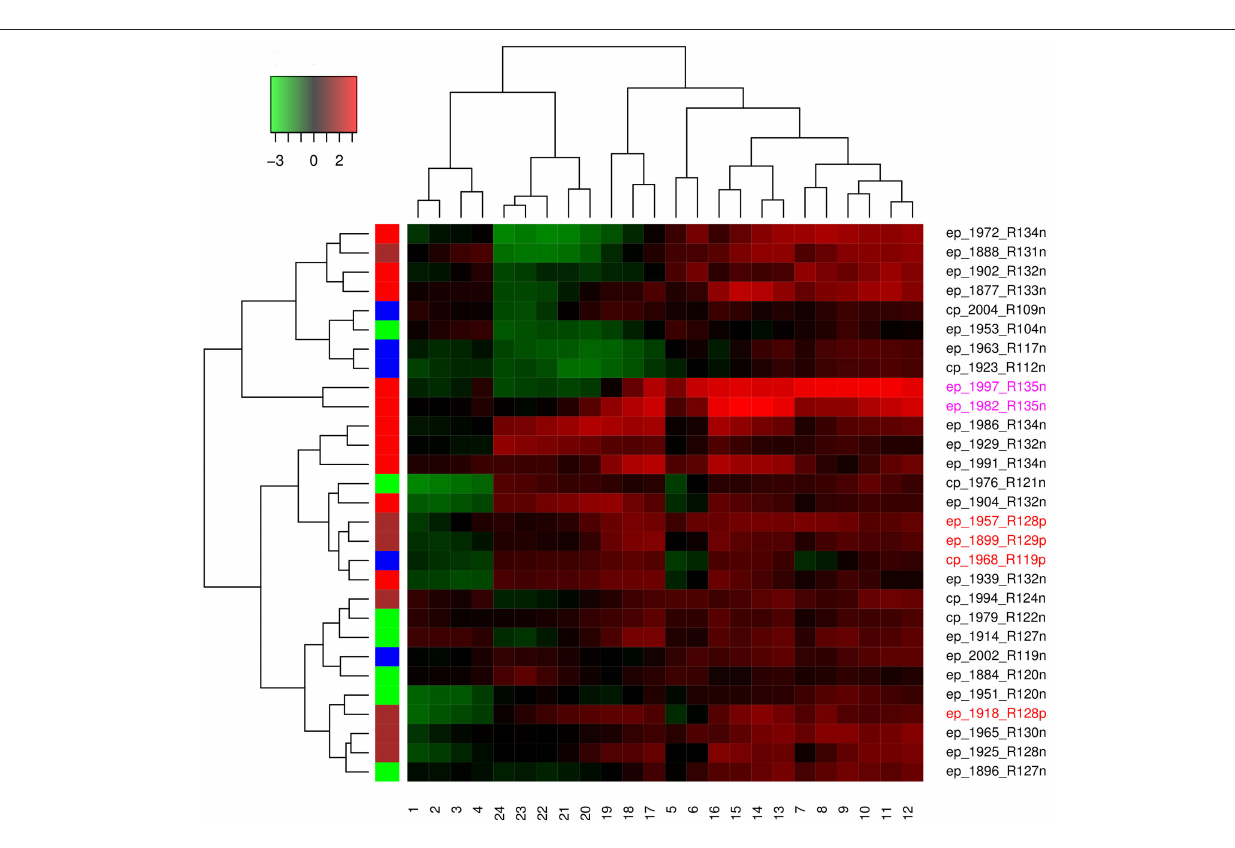
to December), but high from 7 to 16 months (July to April), Figure 5 . Differences in the distribution of ENSO indices in the groups were statistically significant, Kruskal-Wallis test p